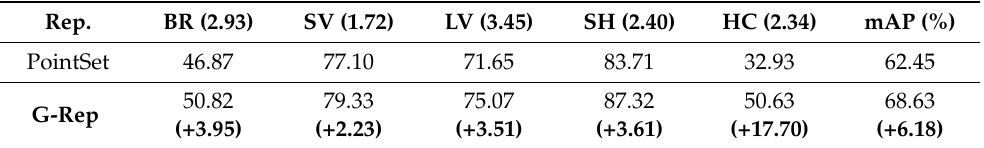
Table 3. Performance comparison of PointSet and G-Rep for large aspect ratio objects. The ratio number in the parentheses next to the category name in the first row is the mean aspect ratio (ratio of the long side to the short side) of all targets in that category.